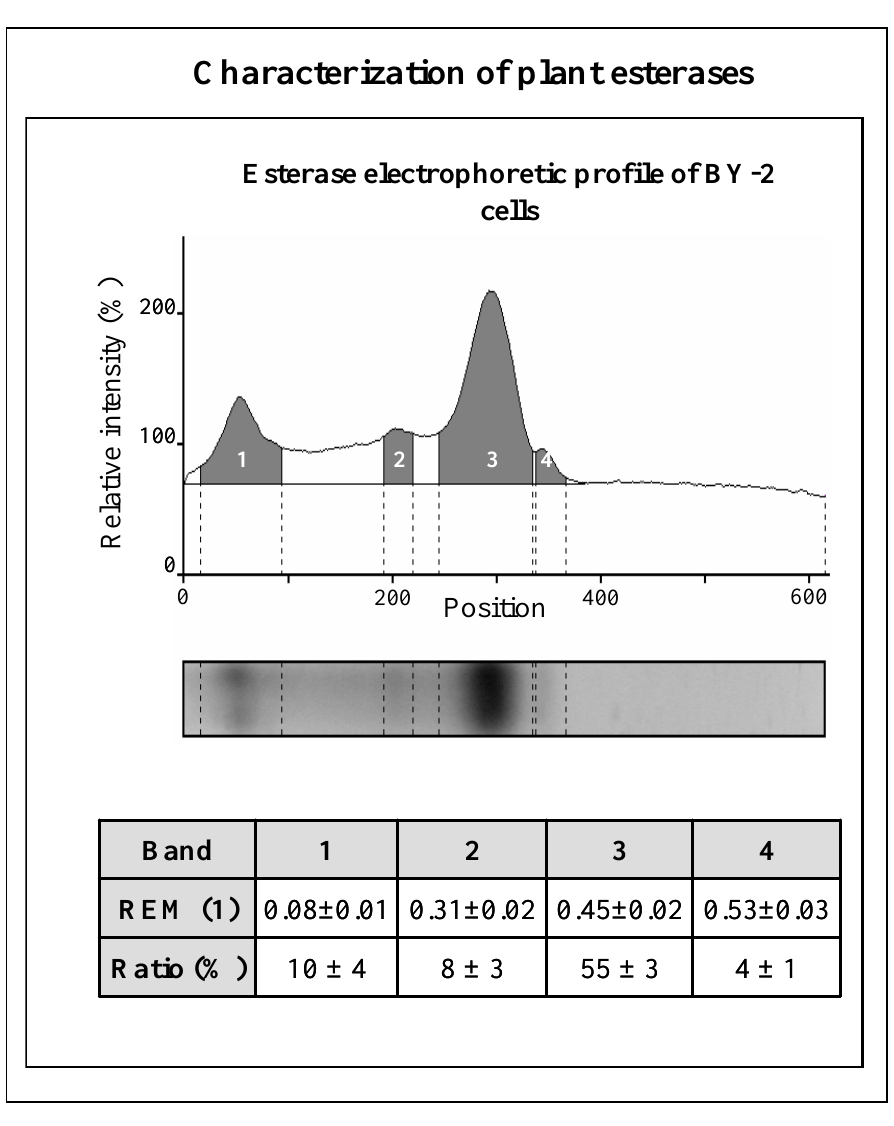
Figure 2. The electrophoretic profile of esterases detected. The typical profile of tobaco BY-2 intracellular esterases obtained by native electrophoresis on 10% polyacrylamide after FDA staining procedure. Inset shows the image of gel in inverted greyscale. Table shows relative electrophoretic mobility (REM) and ratio relative to total activity of particular protein band. Data are expressed as mean value – SD (n=9). For other details, see Materials and methods